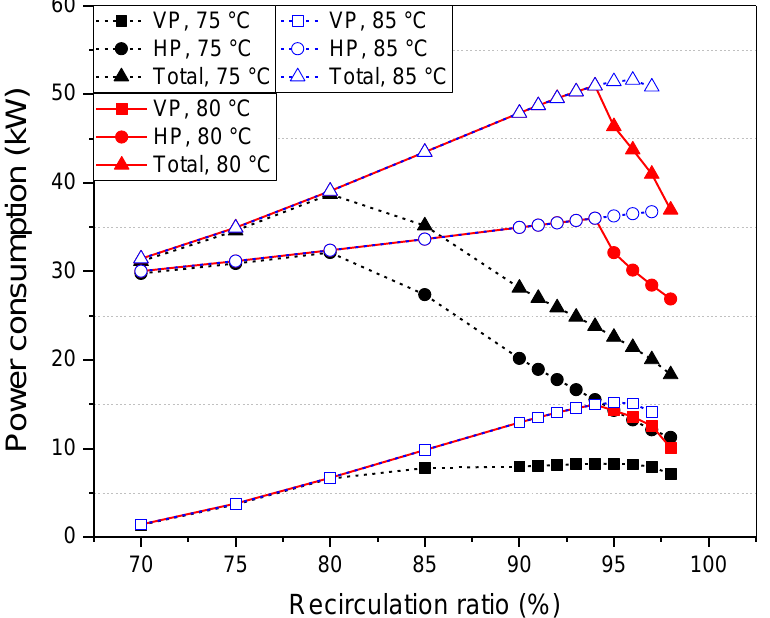
Figure 7. Vacuum pump (VP), heat pump (HP) and total power consumption as recirculation ratio increases for the set-points of 75, 80 and 85 °C.